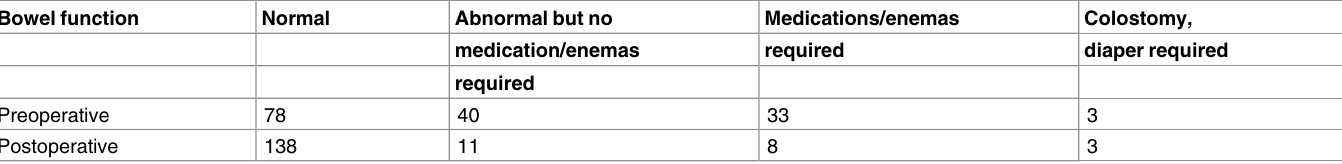
Table 5. Comparison of Pre- and Postoperative Intestinal Sphincter Muscle Function. Bowel